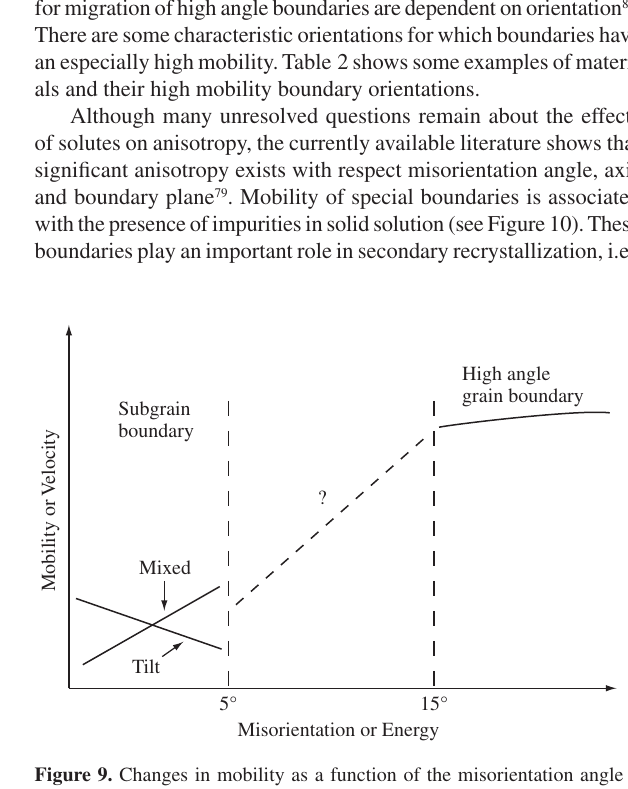
Figure 8. Change in migration rate of the grain boundary V in aluminum as a function of rotation angle in relation to <111> direction 80 .